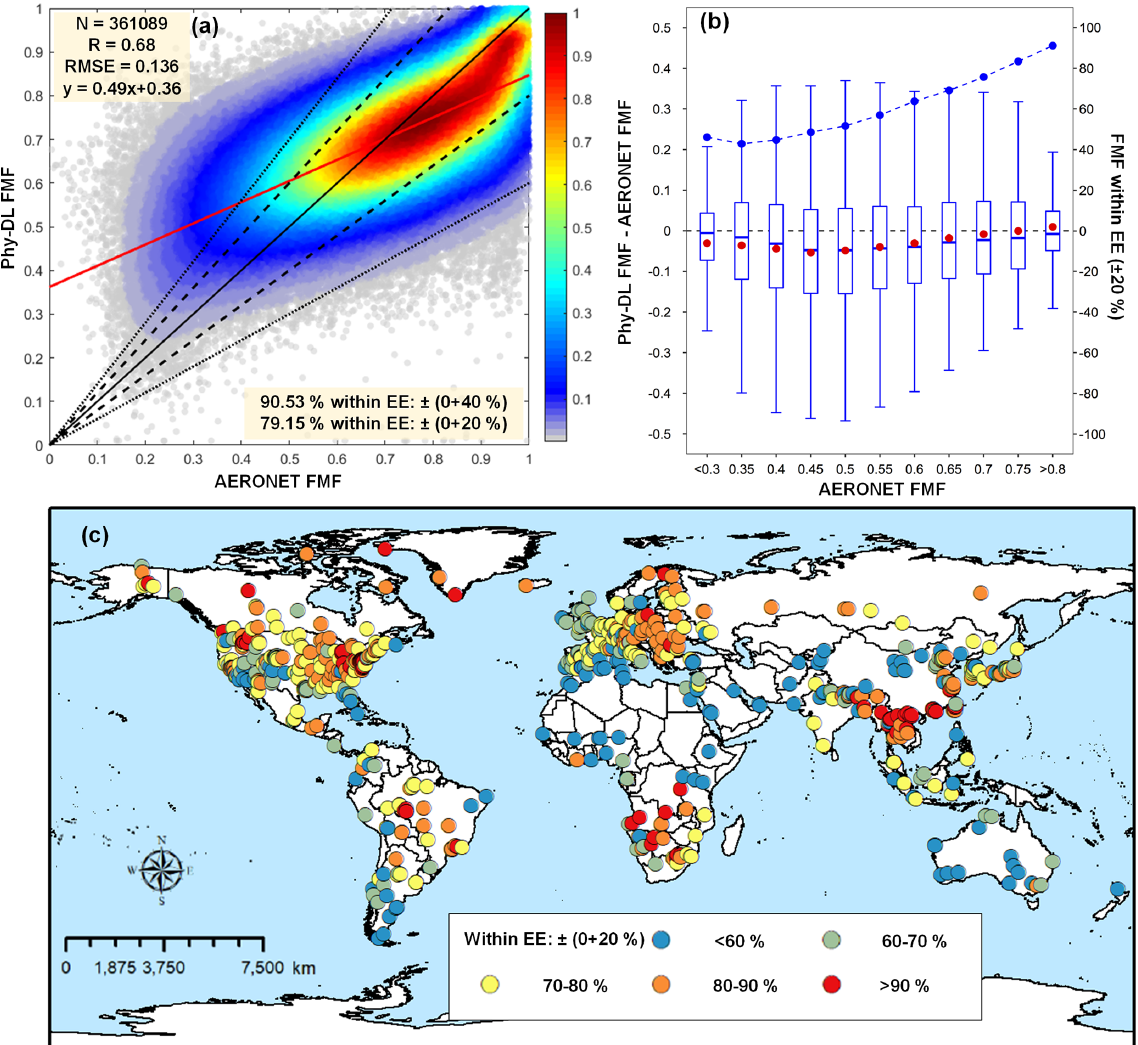
Figure 4. (a) Phy-DL FMF at 500nm as a function of AERONET FMF. The solid black and red lines are the 1 : 1 line and the best-fit line obtained from linear regression, respectively. The dashed and dotted black lines represent the expected error (EE) envelopes of ± 20% and ± 40%, respectively. (b) Box plots of the FMF bias (estimated FMF minus AERONET FMF) as a function of AERONET FMF. The dashed horizontal black line indicates the zero bias. The red dot in each box represents the mean value of the FMF bias. The upper, middle, and lower horizontal lines in each box show the 75th, median, and 25th percentiles, respectively. The blue dots connected by the dashed curve are percentages of FMF retrievals falling within the EE envelope of ± 20%. (c) Global distribution of percentages of Phy-DL FMFs falling within the EE envelope of ± 20% at the AERONET